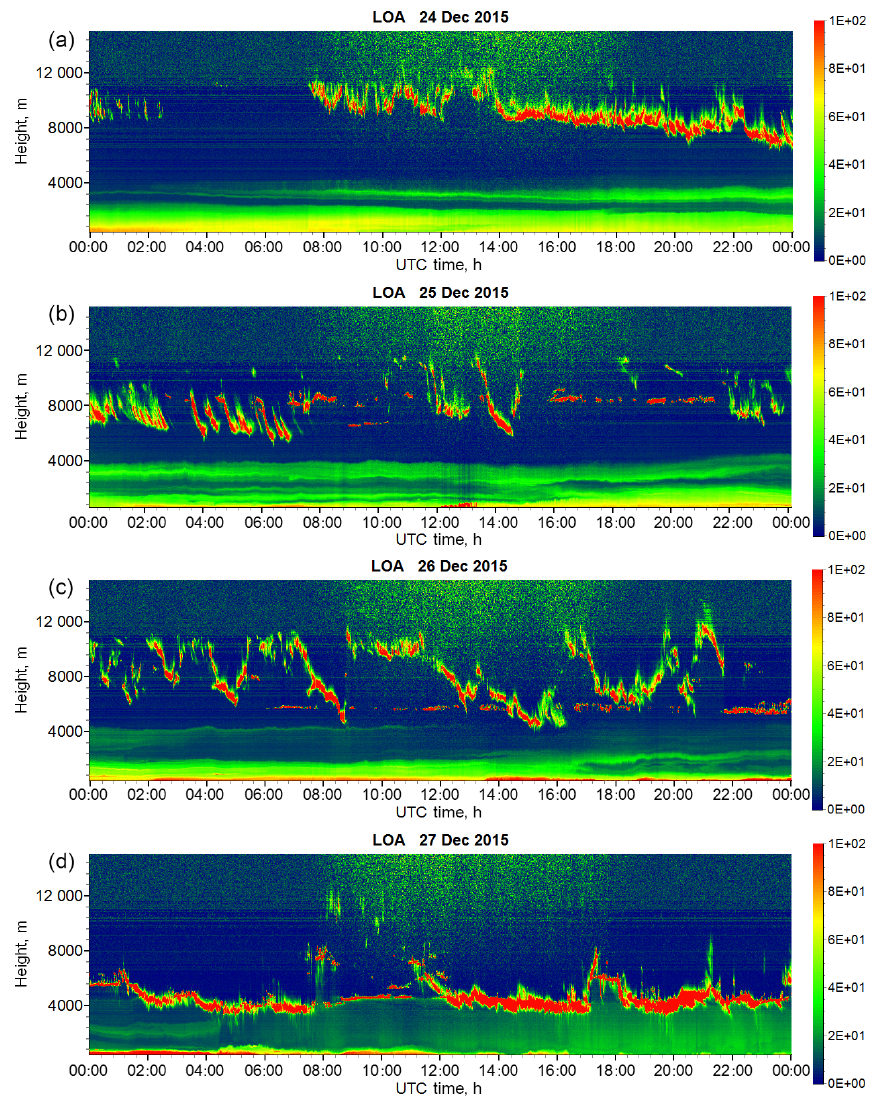
Figure 2. Range-corrected lidar signal (in arbitrary units) of Cimel MPL for 24–27 December